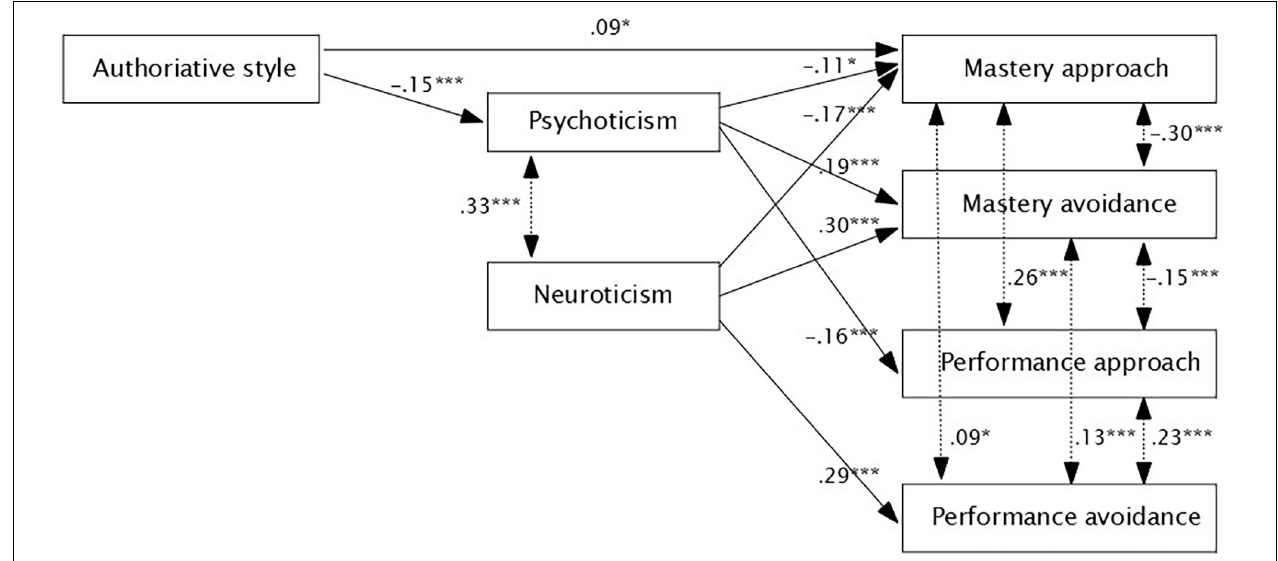
FIGURE 2 | Obtained empirical model. *,***Represents level of